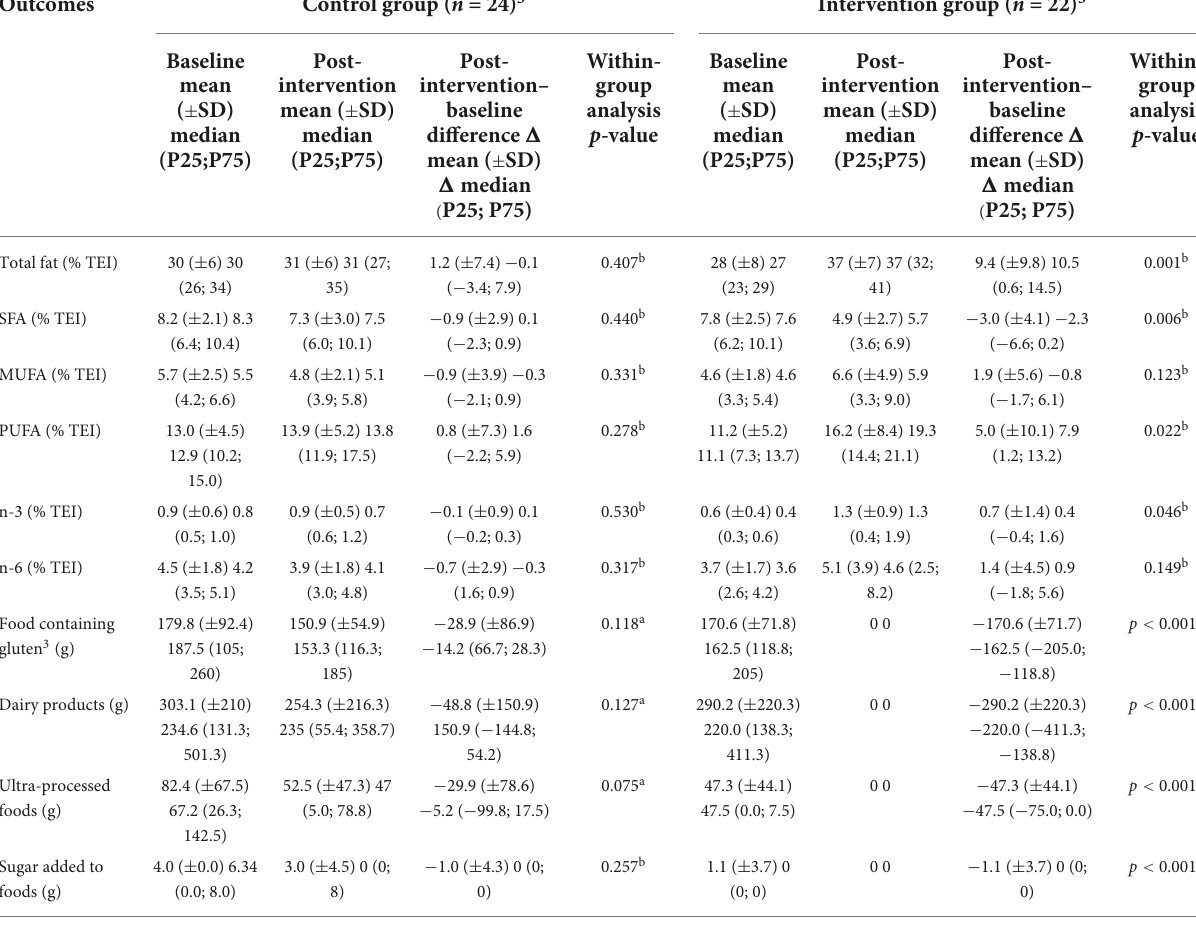
TABLE 2B Dietary intake in control and intervention group at baseline 1 and post-intervention 2 .